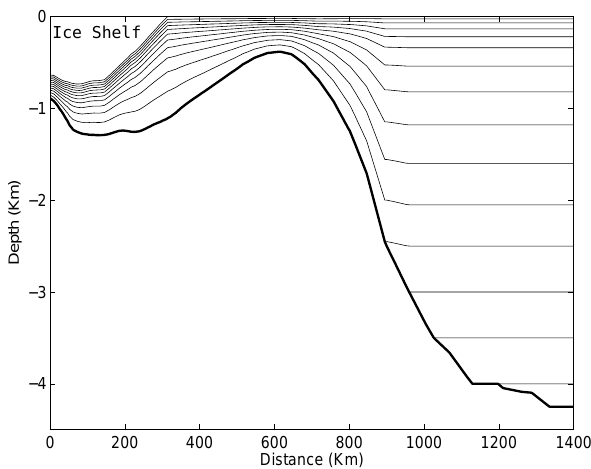
Fig. 5. Schematic of a hybrid vertical grid. The sigma grid is used in Fig. 15. Schematic of a hybrid vertical grids. The sigma grid is used adjunction with ice shelf modelling for the Antarctic region, located in adjunction with ice shelf modeling for the Antarctic region, lo- under the ice shelf and along the continental shelf; z -level grids are used in other parts of the cated under the ice shelf and along the continental shelf. Z -level grids are used in other parts of the ocean.